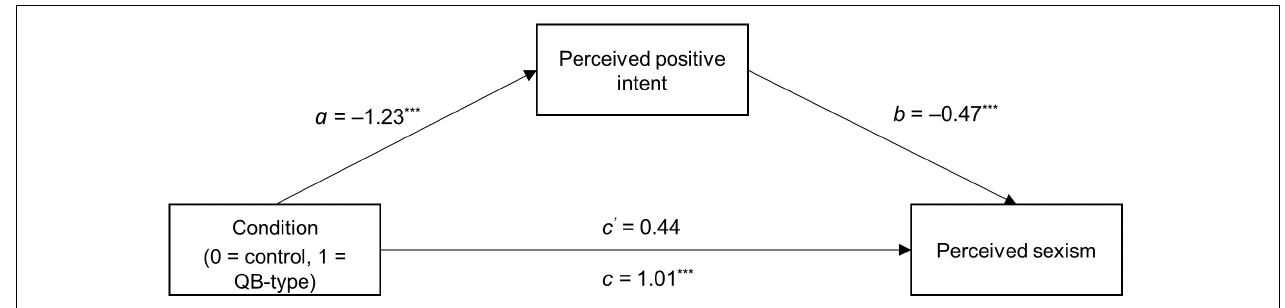
FIGURE 1 | Mediation model for male leader showing effects of QB-type behavior on increased perceived sexism through reduced perceptions of positive intent (partially standardized regression coefficients, ∗∗∗ p < 0.001).